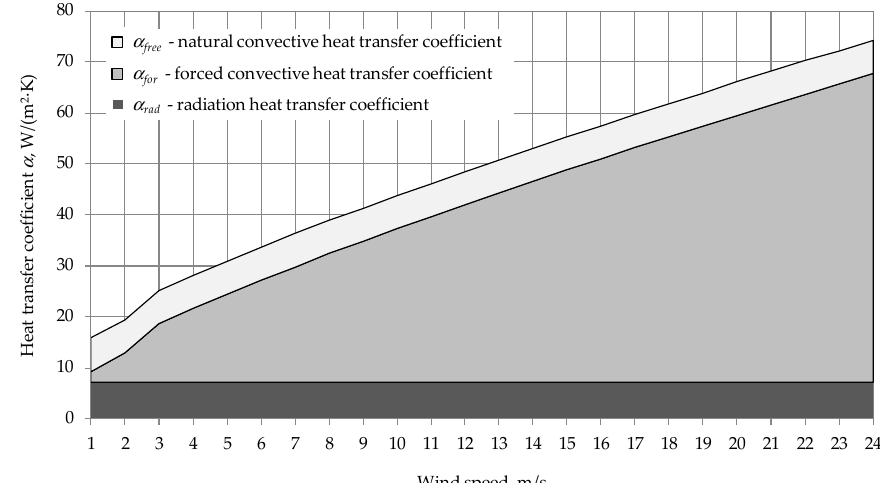
Figure 4. Relationship between the heat transfer coefficient to air α and wind velocity for a d = 3.5m hot mix asphalt (HMA) layer.